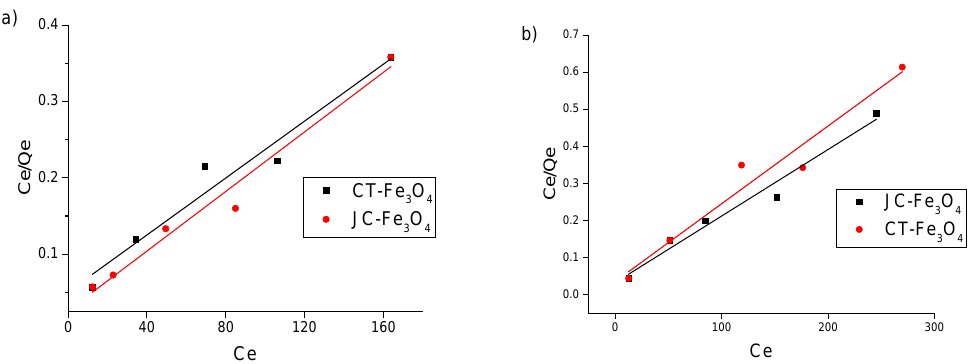
Figure 7. Langmuir isotherm plot for the removal of ( a ) Co 2+ ions and ( b ) Cu 2+ ions by JC-Fe 3 O 4 and CT-Fe 3 O 4 NPs. Table 3. Adsorption isotherm parameters for metal ions onto JC-Fe 3 O 4 and CT-Fe 3 O 4 adsorbents. Table 4. Comparison of maximum adsorption capacity of CT-Fe 3 O 4 and JC-Fe 3 O 4 with other magnetite nanoparticle adsorbents literature values. Adsorbent